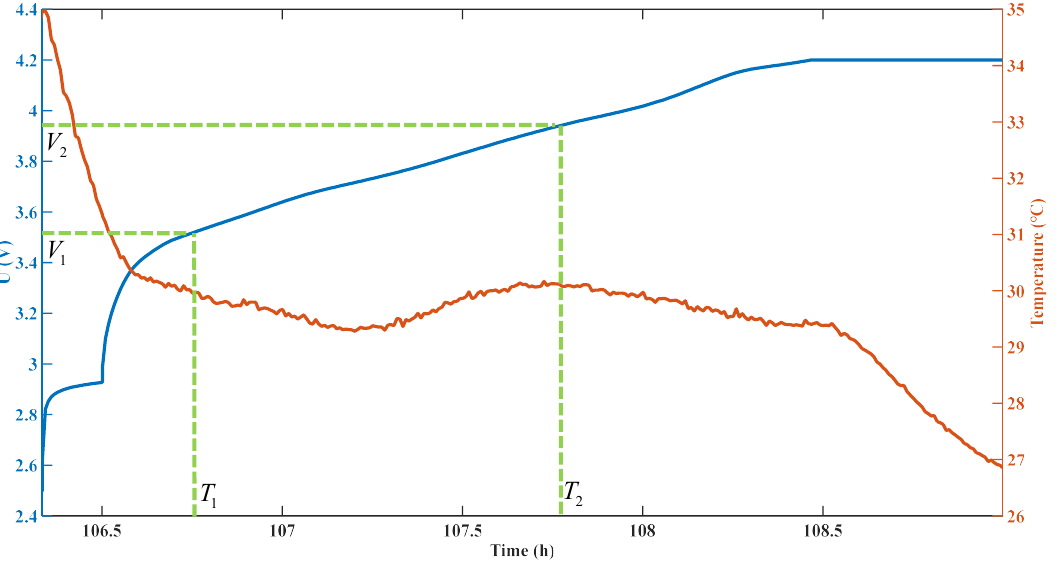
Figure 2. Voltage and temperature data of a cycle in the battery aging test.